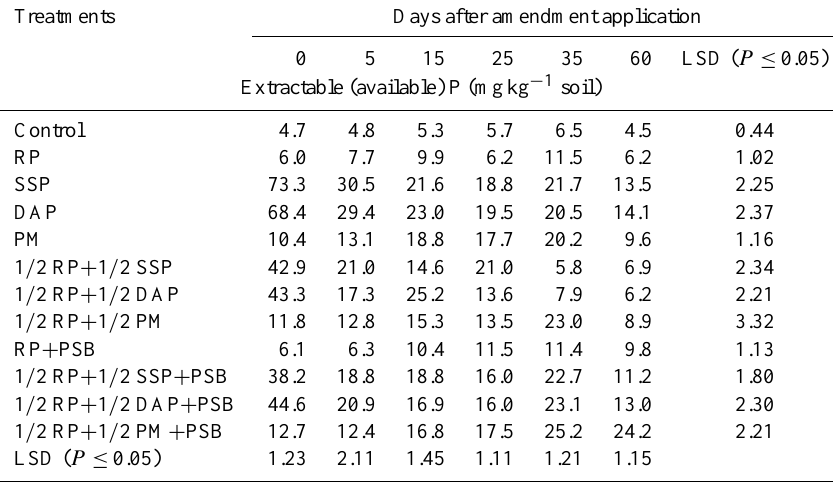
Table 2. Mineralization potential (P release capacity) of soluble P fertilizers and insoluble rock phosphate (RP) in response to phosphate- solubilizing bacteria (PSB) and poultry manure (PM) applied to a loam soil incubated under controlled laboratory conditions at 25 ◦ C over a 60-day